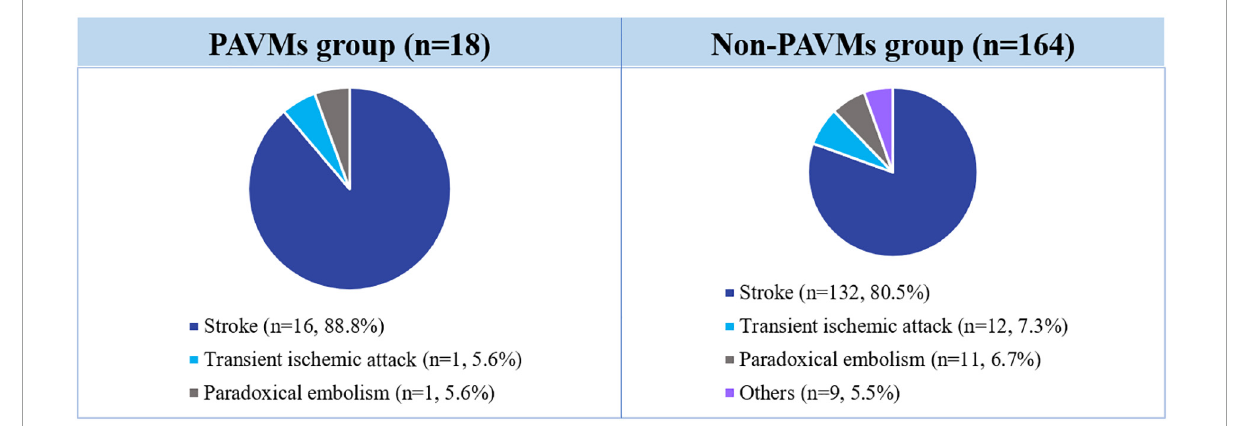
FIGURE3 Incidence of symptoms associated with PAVM requiring TECE with the agitated saline test. TECE, transesophageal contrast echocardiography; PAVM, pulmonary arteriovenous